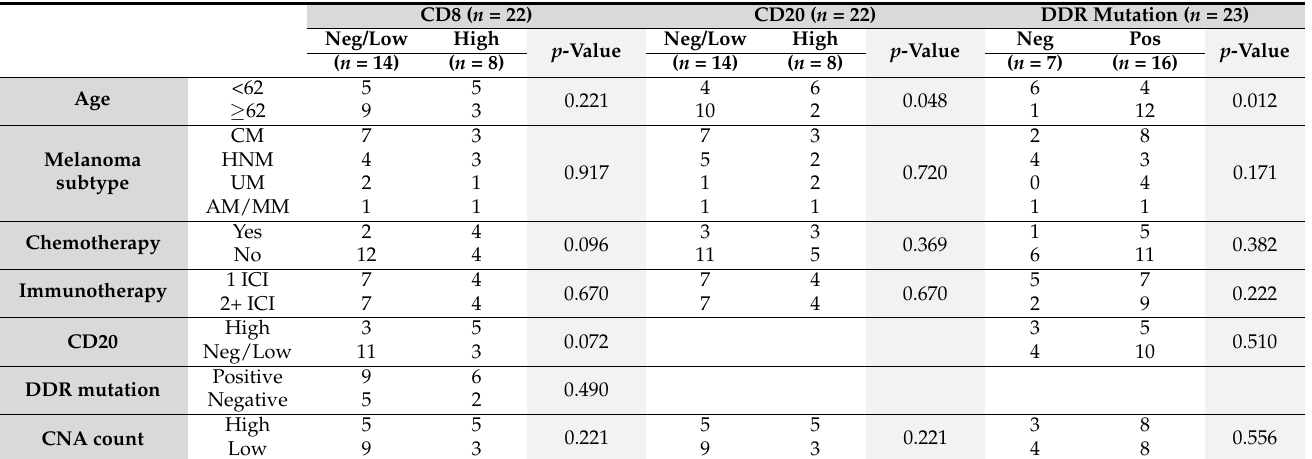
Table 1. Association between the expression of CD8, CD20 expression, DDR gene mutations, CNA count and clinical features.